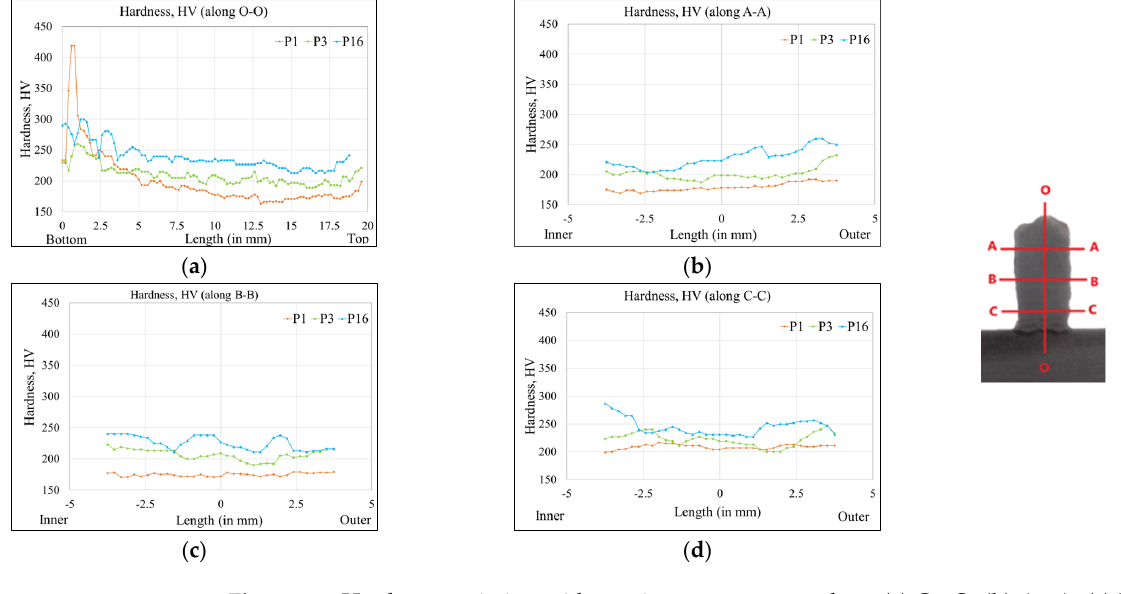
Figure 12. Hardness variation with passive management along ( a ) O − O, ( b ) A − A, ( c ) B − B and ( d ) C − C.